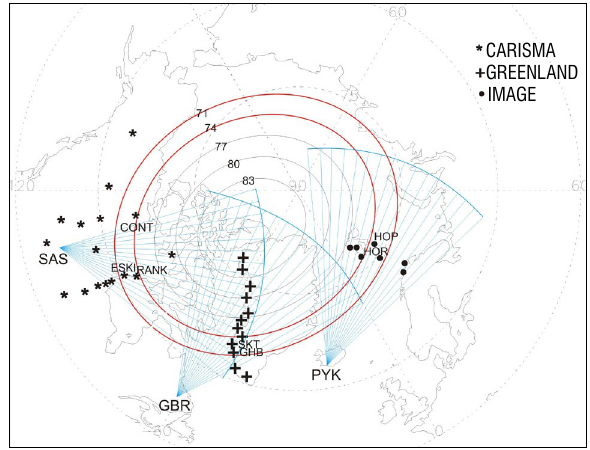
Figure 3: Fields of view of the SuperDARN radars at Saskatoon (SAS), Goose Bay (GBR) and Þykkvibaer (PYK), plotted according to geographical coordinates. The solid lines indicate the altitude- adjusted corrected geomagnetic (AACGM) magnetic latitude.